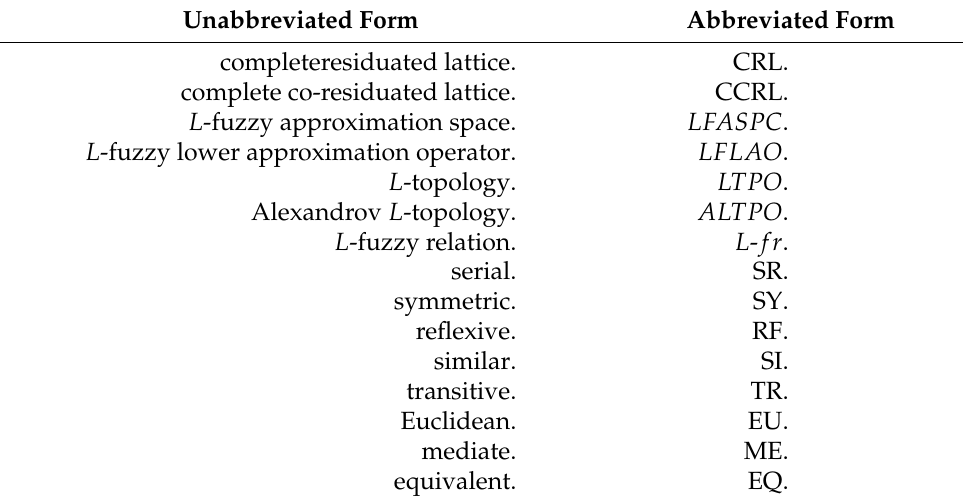
Table 1. Abbreviation table. Unabbreviated Form Abbreviated Form completeresiduated lattice. CRL. complete co-residuated lattice. CCRL. L -fuzzy approximation space. LFASPC . L -fuzzy lower approximation operator. LFLAO . L -topology. LTPO . Alexandrov L -topology. ALTPO . L -fuzzy relation. L - fr . serial. SR. symmetric. SY. reflexive. RF. similar. SI. transitive. TR. Euclidean. EU. mediate. ME. equivalent.